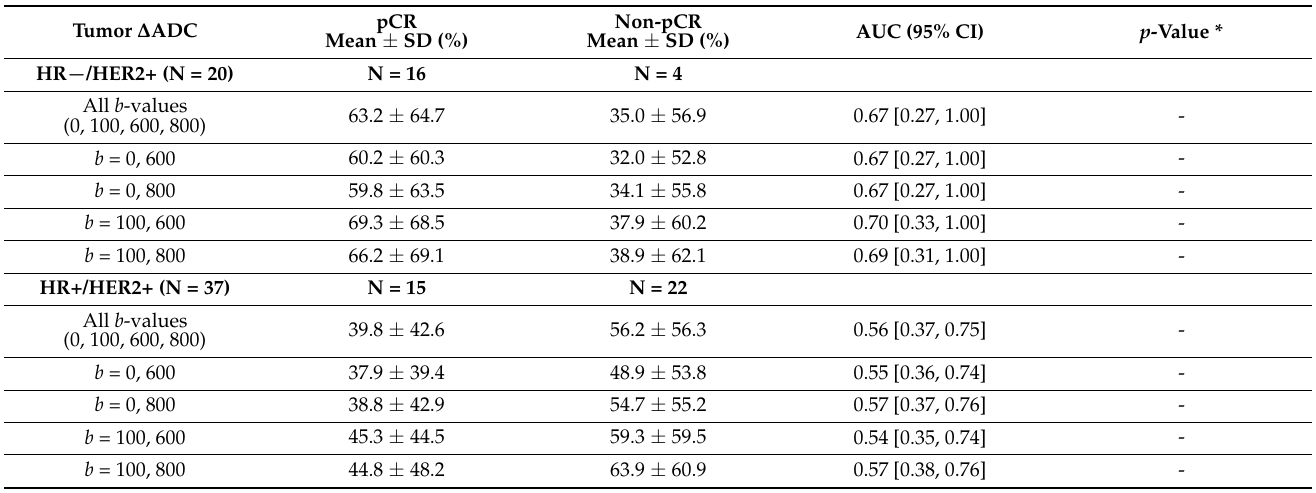
* p values for non-inferiority test of AUC versus that of the reference ADC metric using all b -values, with a non-inferiority margin of 0.02, calculated only for the HR+/HER2 − subtype when the corresponding test for all cancers was rejected. Abbreviations: ADC, apparent diffusion coefficient; AUC, area under the ROC curve; CI, confidence interval; SD, standard deviation; pCR, pathologic complete response; HR, hormone receptor; HER2, human epidermal growth factor receptor 2.